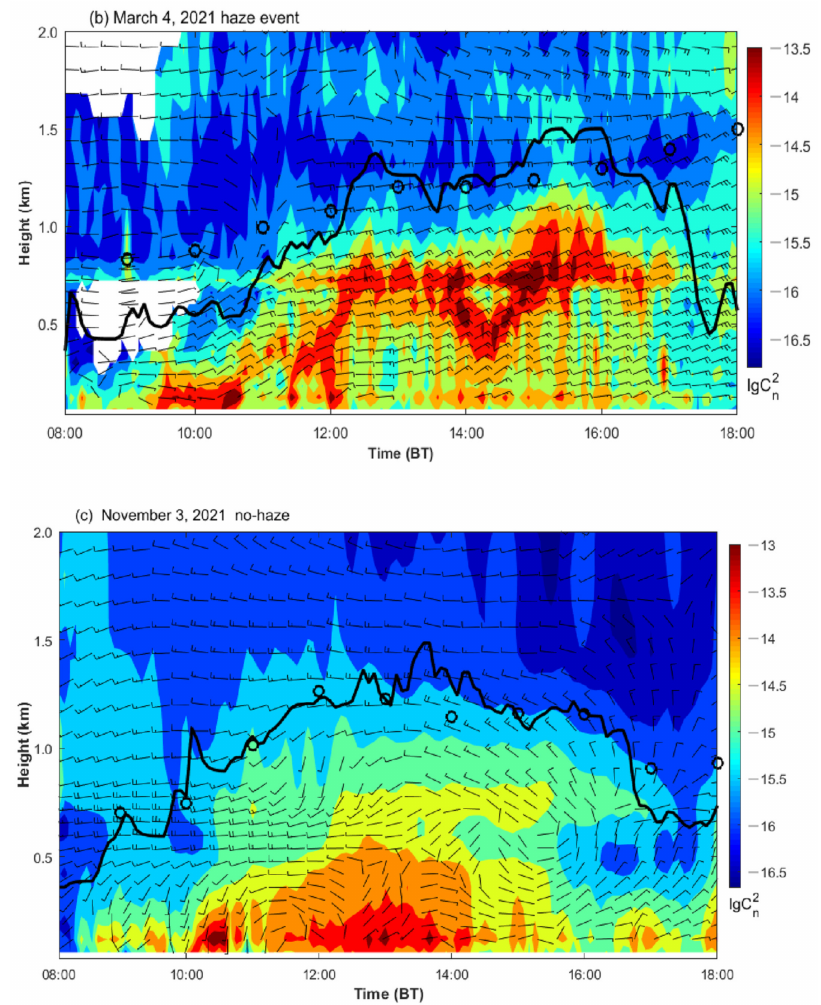
Figure 2. Comparison of BLHs (black line) inversed by CFL and BLHs (black circle) from ERA-Interim; ( a ) 8:00–18:00 on 4 November 2016; ( b ) 8:00–18:00 on 4 March 2021; ( c ) no-haze event 8:00–18:00